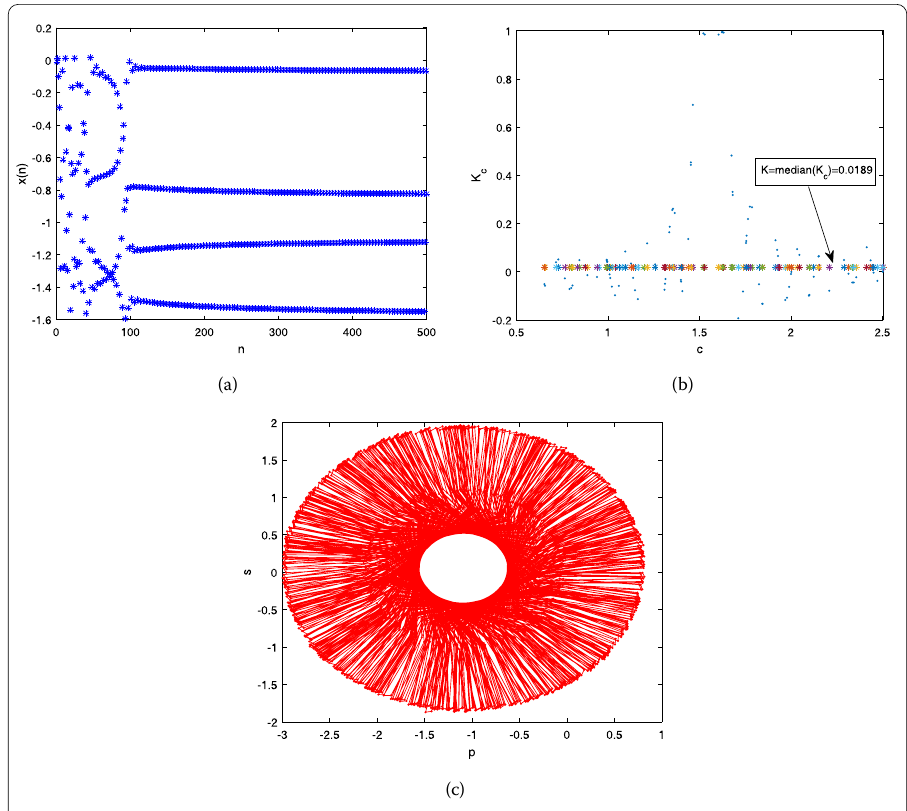
Figure 7 The NSP trajectories. The chaotic solutions ( a ), K median value ( b ) and ( p , s ) dynamics ( c ) of system (10) for a = 1, b = 1 and v = 0.5